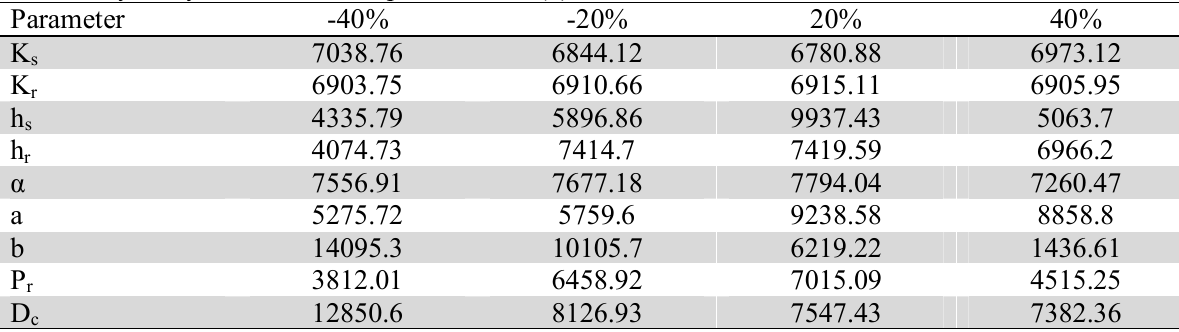
Sensitivity analysis the total cost per unit time